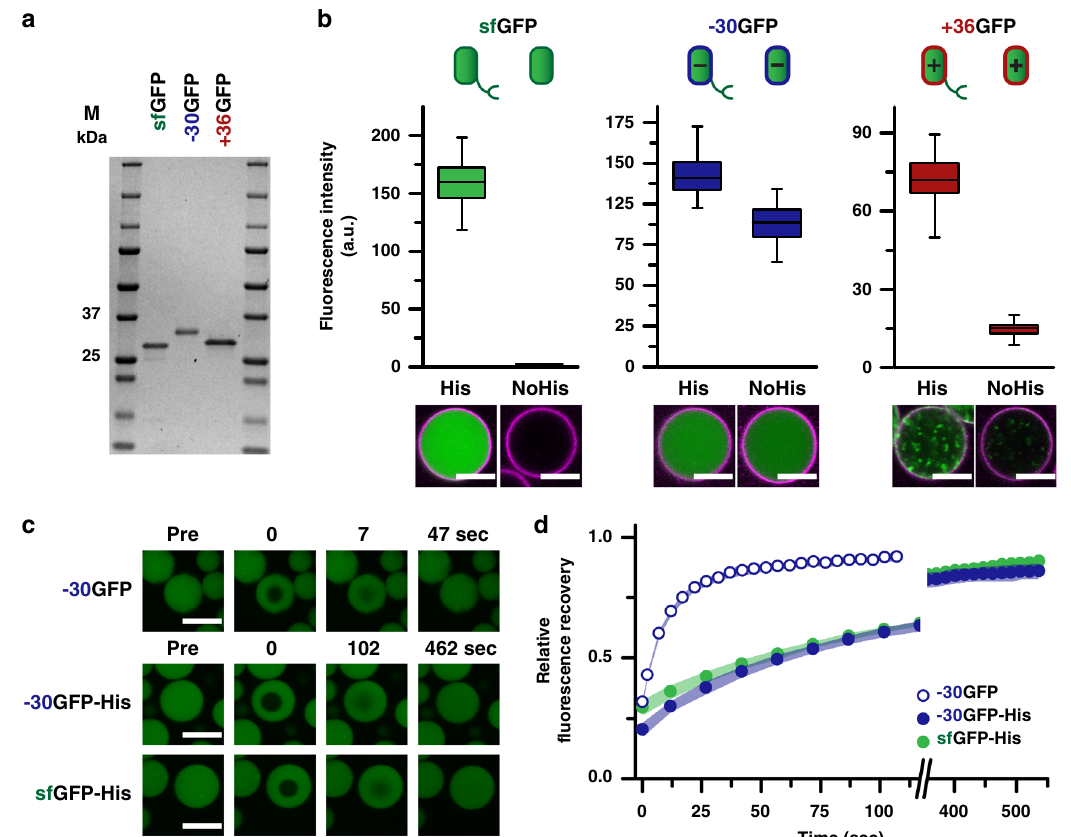
Fig. 3 Detailed characterization of the Ni 2 + -NTA/His uptake mechanism. a Analysis of the puri fi ed GFP variants by SDS-PAGE analysis. Left to right: marker (M), puri fi ed sfGFP-His, puri fi ed − 30GFP-His, + 36GFP-His, M. For all three GFP variants, a prominent band is observed at the expected molecular weight. b Analysis of coacervate populations containing either the His-tagged or No His variant of each supercharged protein. Charge is indicated by color; green, neutral; blue, negative; and red, positive. For all cases, n > 60. The membrane is stained with Nile Red, scale bar: 10 µ m. Uncropped images are available in Supplementary Fig. 12c, d. FRAP analyses of protein-loaded coacervate protocells. c Confocal micrographs at different time points during the recovery experiments. Scale bar: 10 µ m. d Analysis of the fl uorescence recovery over time. Open blue circles, − 30GFP without His-tag; closed blue circles, − 30GFP-His; and green circles, sfGFP-His. Shaded areas represent the standard deviation of three individual measurements. The unbroken graph and data fi ts are available in Supplementary Figs. 14 and